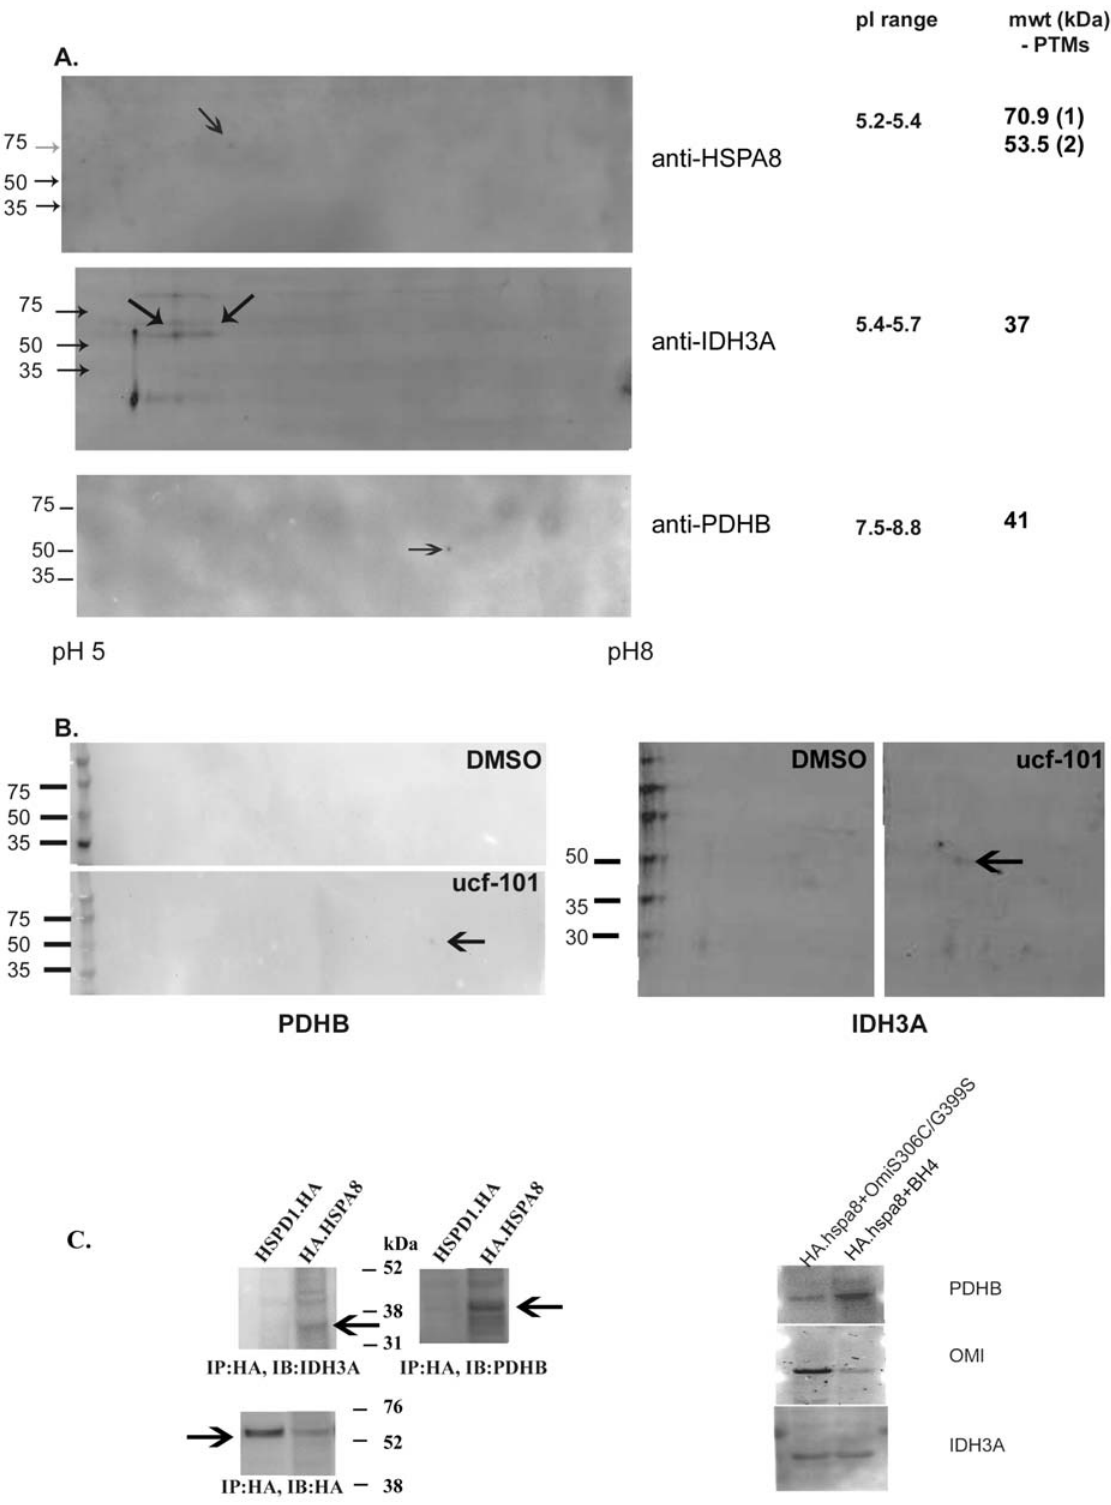
Figure 3. Validation of candidates’ ability to interact with HSPA8 and be degraded by HtrA2 Representative immunoblots (A) of IEF/2D separated, post-IP mitochondrial proteins from HEK293 cells expressing the FLAG.OMI.S306C mutant. Arrows indicate immunoreactive spots according to the antibody used. (B) Samples were also incubated in the presence/absence of ucf-101 with recombinant HtrA2/ OMI and separated and immunoblotted as above. Arrows indicate the species that correlated to the results in (A) and that persisted in the presence of ucf-101, but were absent without inhibition of OMI. (C) Immunoblots of anti-HA immunoprecipitated proteins. Arrows indicate immunoreactive spots according to the antibody used. HA.HSPD1 was used as a mitochondrially-targetted HA-tagged protein control.